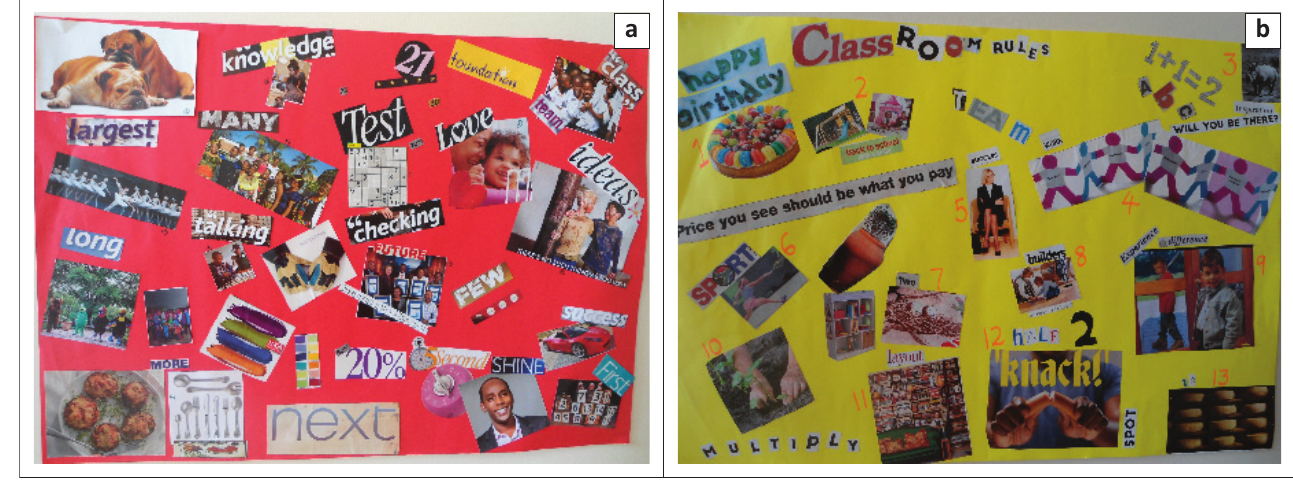
FIGURE 4: Collages a and b depicting an integrated learning approach.